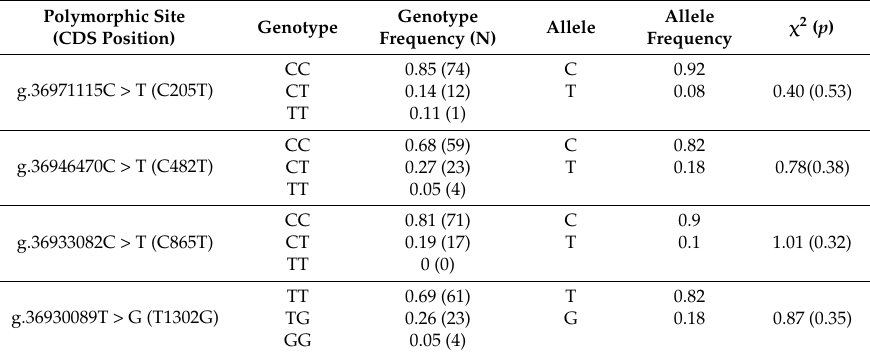
Table 2. Allele and genotype frequencies of B4GALNT2 in Small Tail Han (STH) ewes. Polymorphic Site Genotype Genotype (CDS Position) Frequency (N)